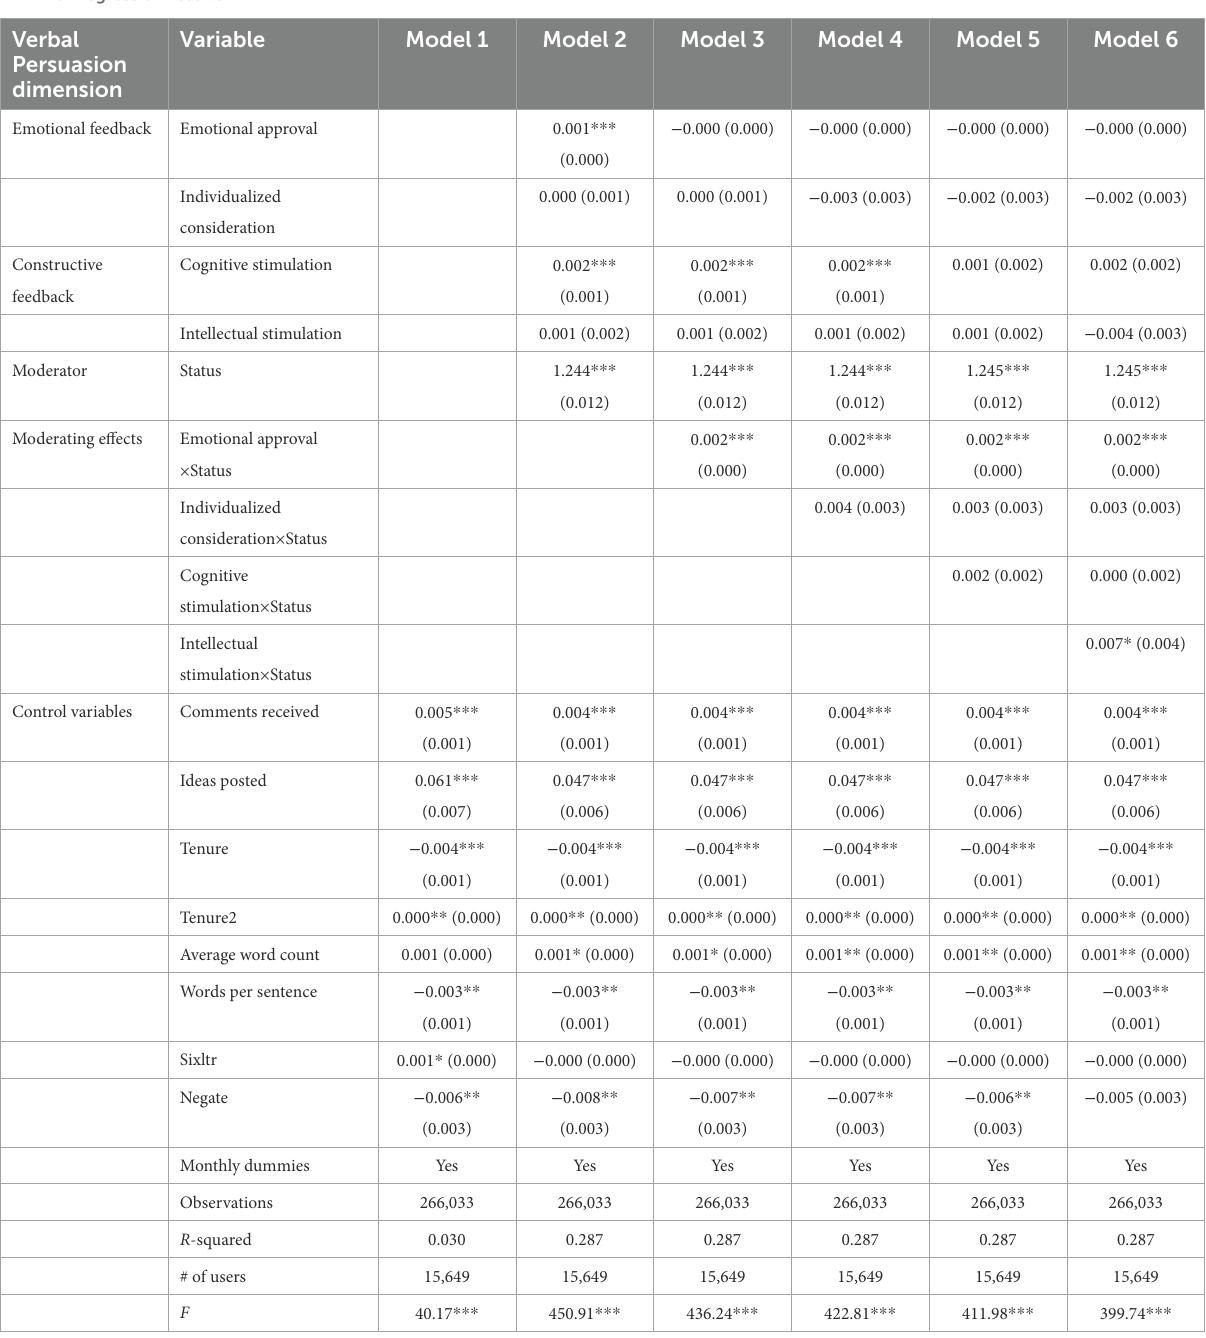
TABLE 5 Regression